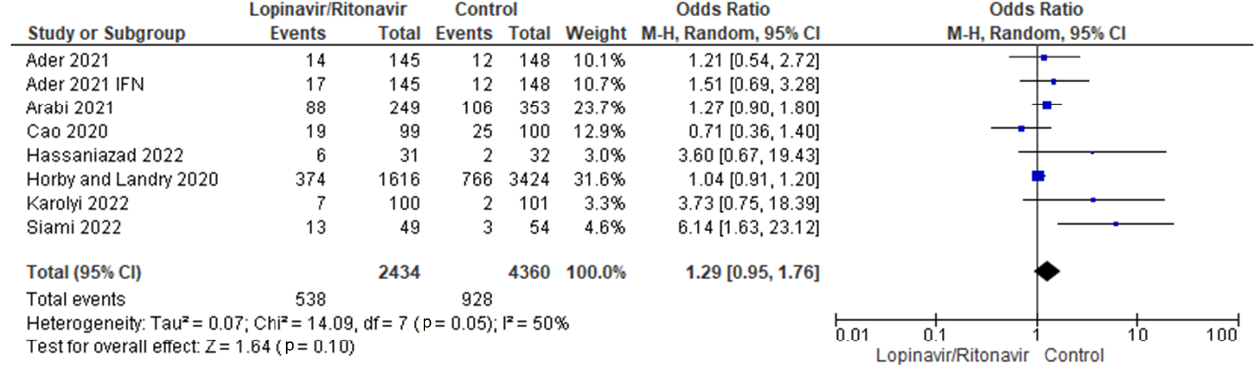
Figure 3. Forest plot analysis for mortality incidence. The sizes of the blue squares reflect the relative weight of the individual trials. The combined point estimate is shown as a black diamond. The diamond and the squares (together with the 95% CIs) located beyond the vertical line (indicating the unit value) show that a result was statistically significant.